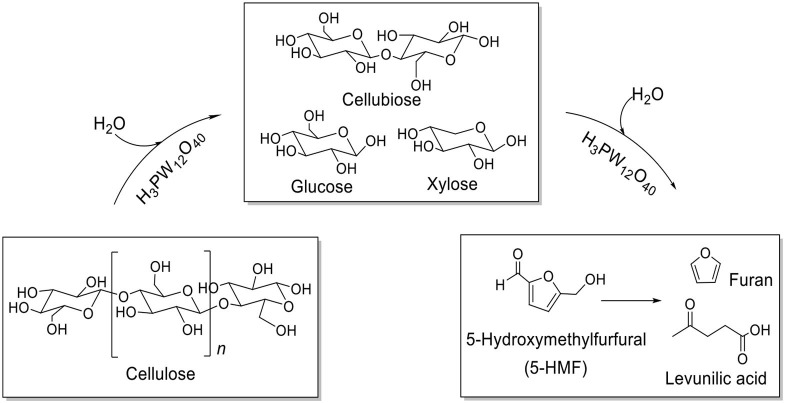
Main products and by-products of cellulose conversion by an acid catalyst H3PW12O40.